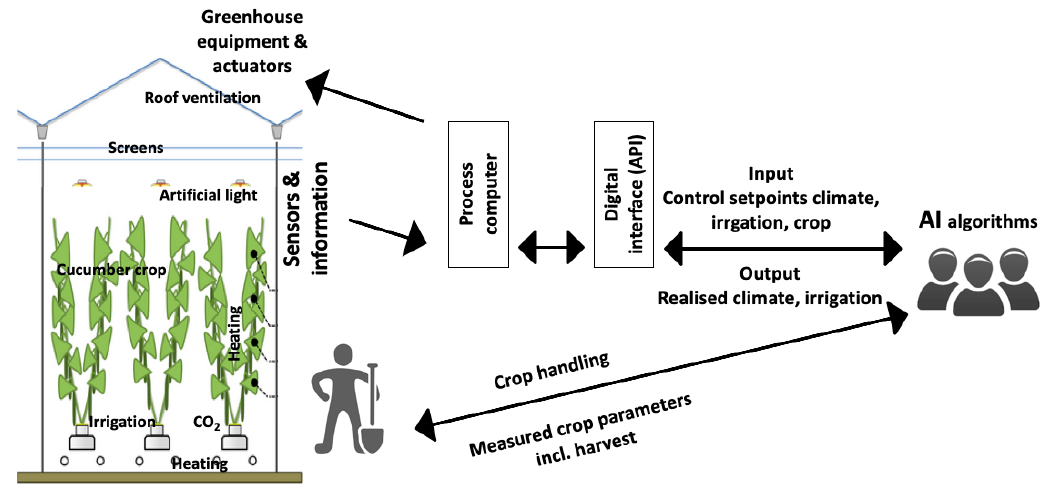
Figure 2. Scheme of data exchange from the teams and their AI algorithm via a digital interface (REST API) towards the process computer and the greenhouse actuators and data from sensors via the same way back, data exchange between teams and workers on crop handling, and measured crop parameters.